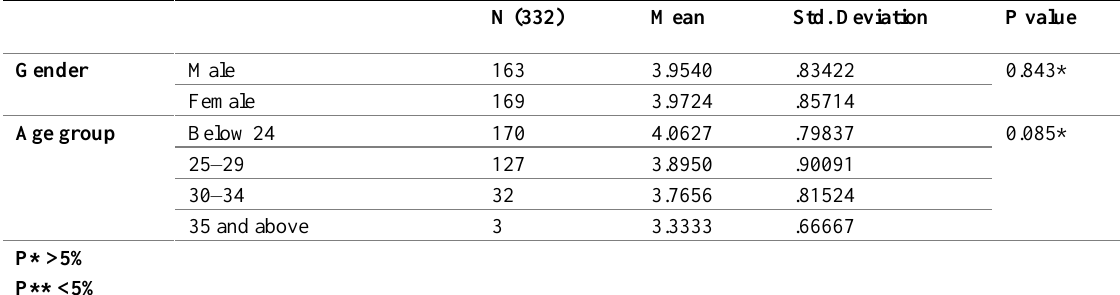
Table 1: ANOVA test of gender, age group and entrepreneurship intention N (332) Mean Std. Deviation P value